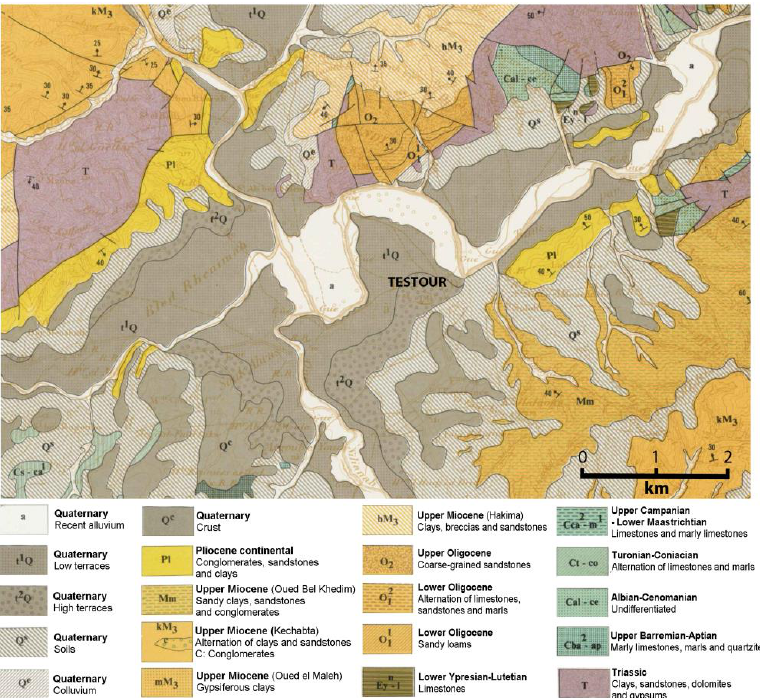
Figure 3. Geological context of the study area. Drawn by the author and based on the geological map of Tunisia, 1:50,000, sheet 26, Oued-Zarga [45].